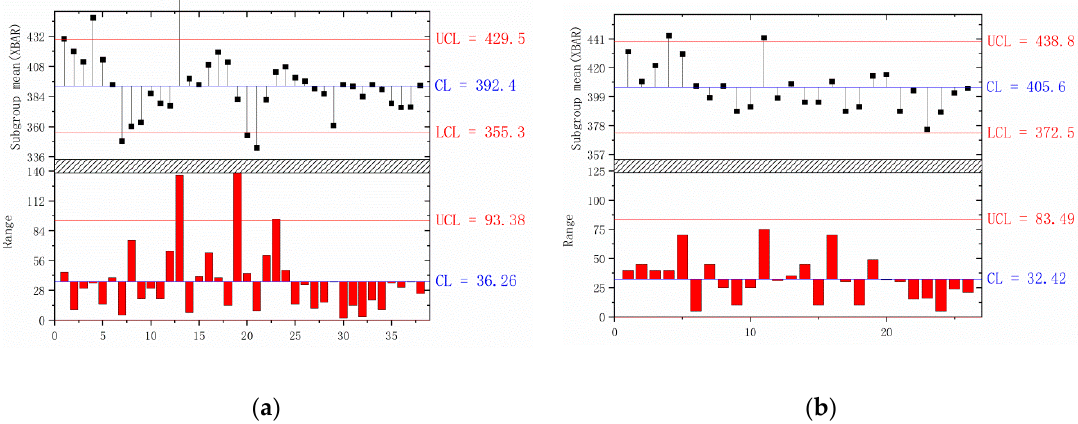
Figure 15. QC analysis of yield strength with different S contents of ( a ) w(S) ≥ 0.007%; ( b ) w(S) ≤ 0.004%.